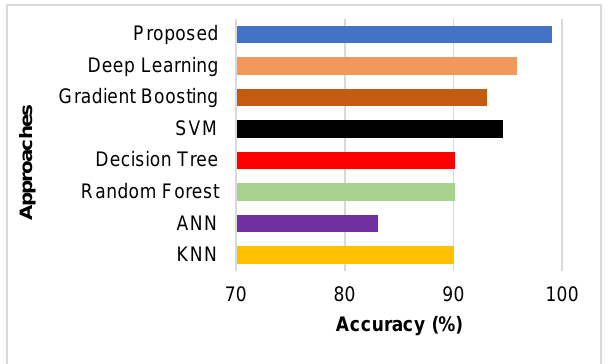
Figure 6. Comparative analysis of accuracy.